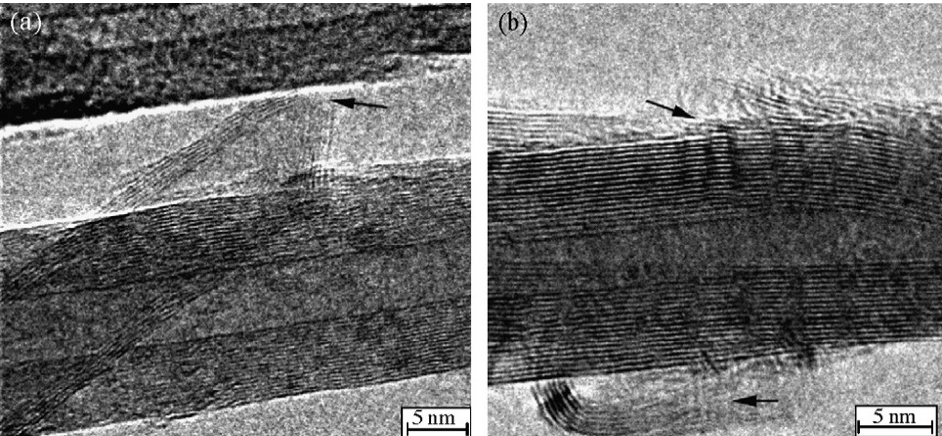
Figure 11. HRTEM images of etched CNTs. The black arrows in figures represent the etched position. Reproduced with permission from Shubin Yang, Electrochemical performance of arc-produced CNTs as anode material for lithium-ion batteries; published by Elsevier, 2007 [93]. Etching treatment effectively improves the recycling capacity of CNTs, while the irreversible capacity of CNTs after acid etching increases by 100 mA h g − 1 compared with the original CNTs. This result is probably due to the formation of a large number of active functional groups which can promote electrolyte decomposition during acid corrosion and oxidation, and heat treatment can effectively alleviate this irreversible capacity increase. However, the defects produced by etching treatment are often accompanied by the decrease of Coulomb